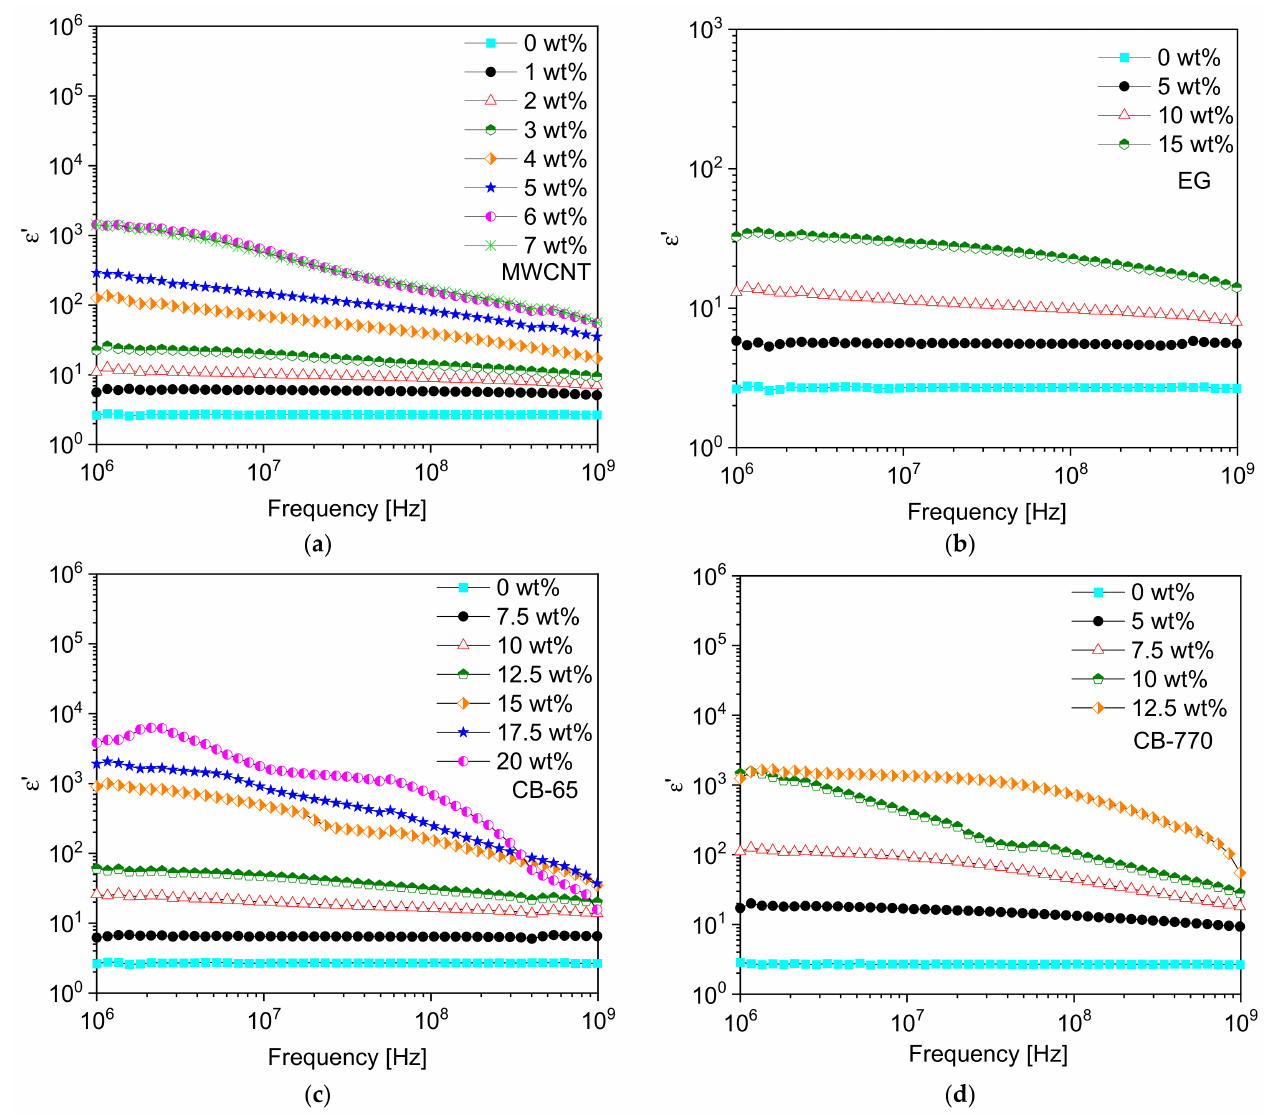
Figure 4. Real permittivity ε ’ of ( a ) MWCNT, ( b ) EG, ( c ) CB-65, ( d ) CB-770 nanocomposites, respectively. Neat PP has a low dielectric constant (2.2), which is independent by the